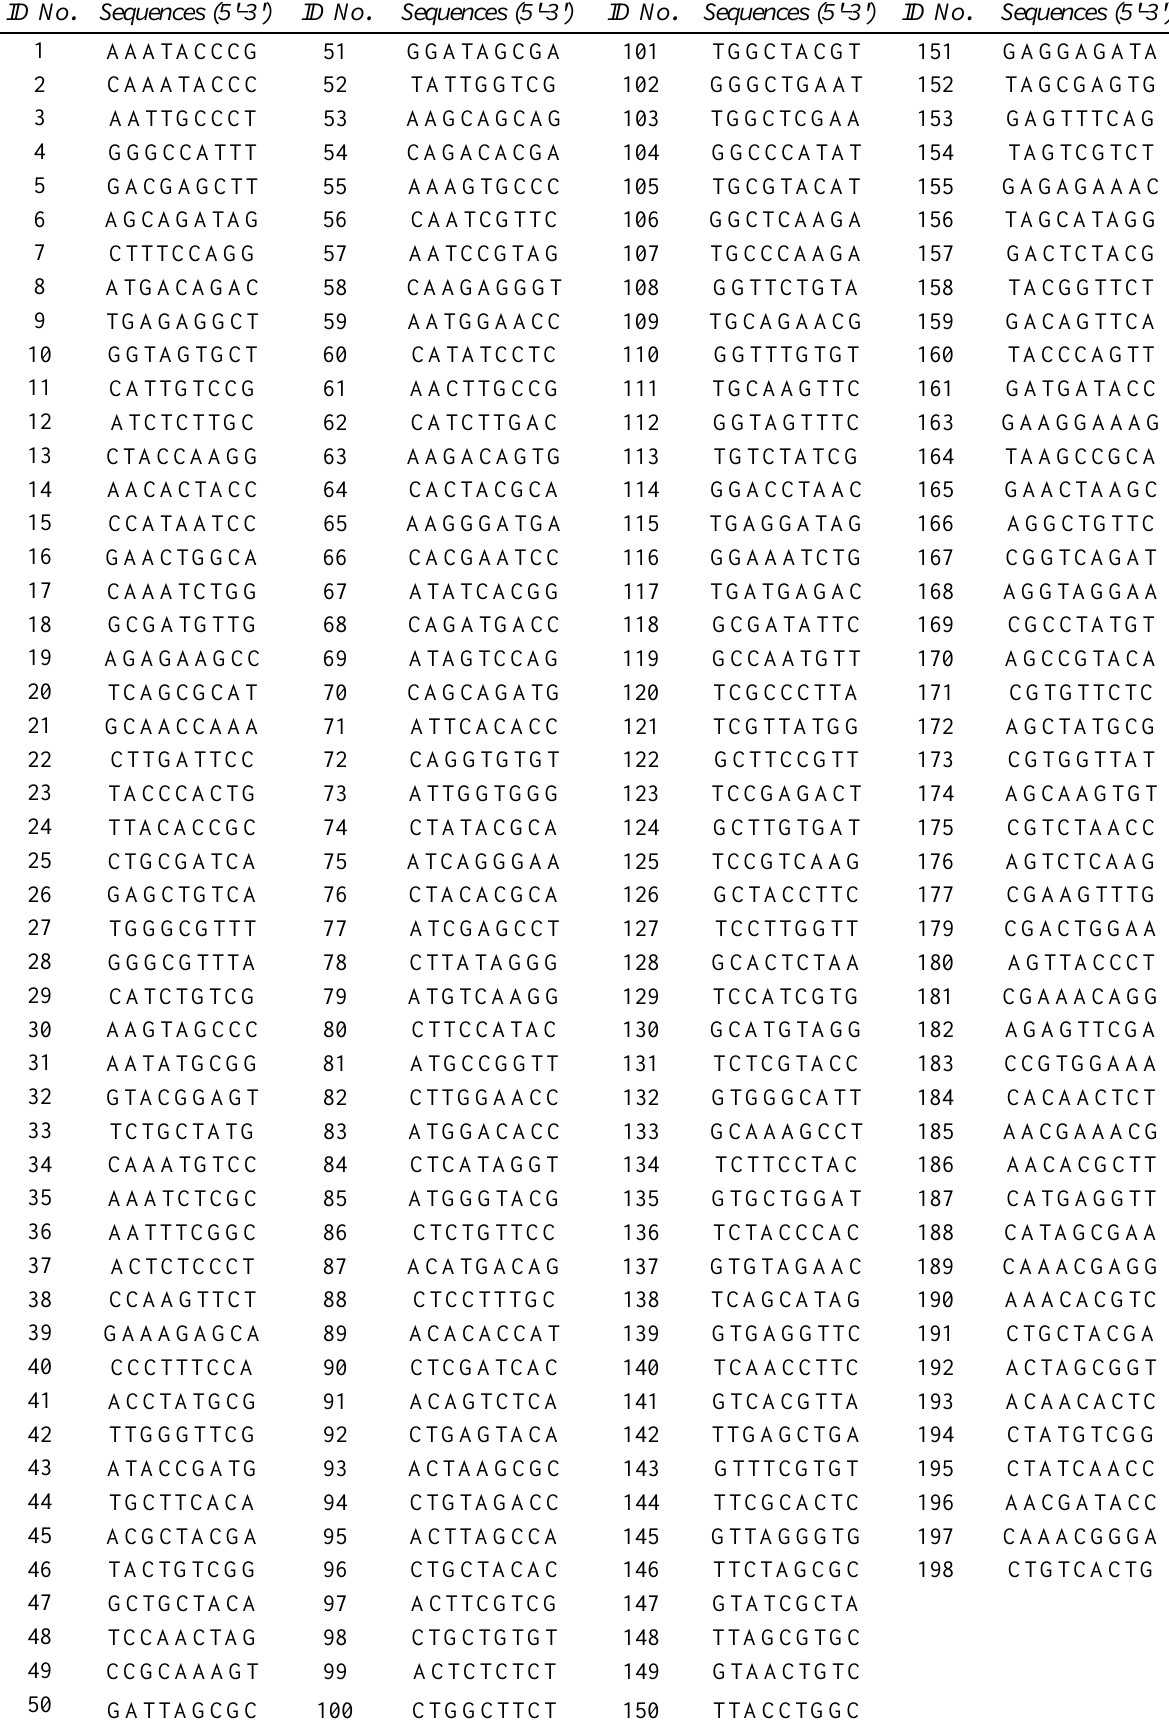
Table 1: Microarray Oligonucleotide Probes ID No. Sequences (5'-3') ID